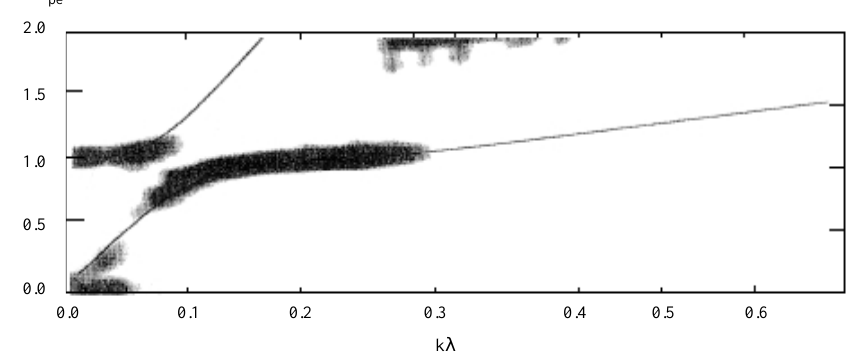
Fig. 12. Wave spectrum from a Vlasov simulation (from Shriver et al., 2000). The real frequency ( ω ) is normalized to the total electron plasma frequency ( ω pe ); the wavenumber ( k ) is multiplied by the cold electron Debye length, ( λ